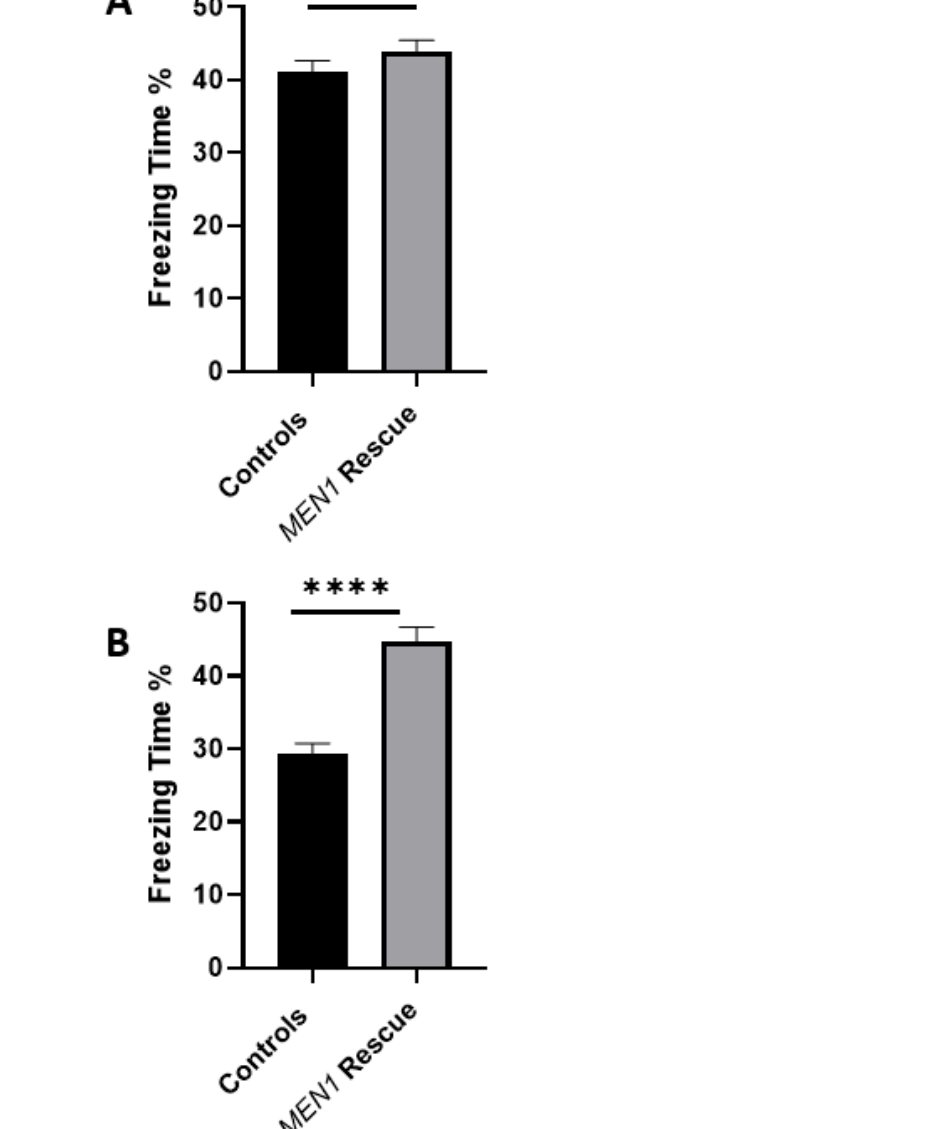
Figure 11. Contextual fear conditioning deficits reversed in the MEN1 rescue mice. ( A ) For the contextual fear conditioning test, mice were trained and analyzed for freeze response. The scores of the freezing time (%) for the control mice and the MEN1 rescue on day 1 were compared, and they show little difference; ( B ) MEN1 rescue animals had a higher freezing time (%) score on Day 2 compared to the controls. Freezing response is the percentage of time spent freezing from the total time duration. Data represent the mean ± SEM. Here, n = 12 mice per group. Statistical significance (Mann–Whitney U test), **** p < 0.0001, ns p > 0.05.